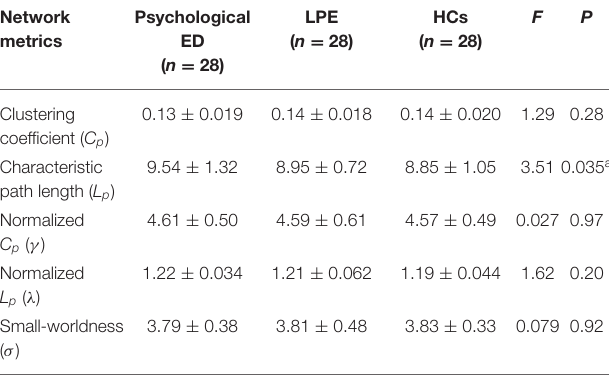
TABLE 2 | Differences of small-world measures in the white matter brain networks.